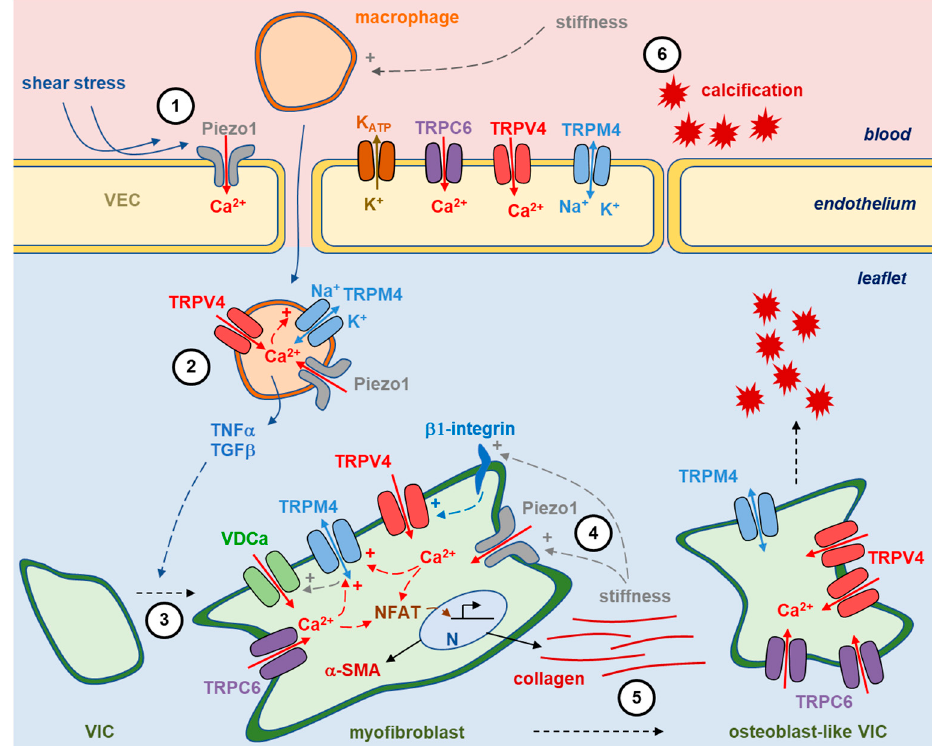
Figure 2. Ion channels in aortic valve remodeling. Cartoon highlighting the three main cell types which participate in aortic valve remodeling with main ion channels involved in the phenomenon. Note that several actors were demonstrated specifically in aortic valves, while others remain to be confirmed, as indicated in the main text. 1 —Valvular insults, such as mechanical stress,